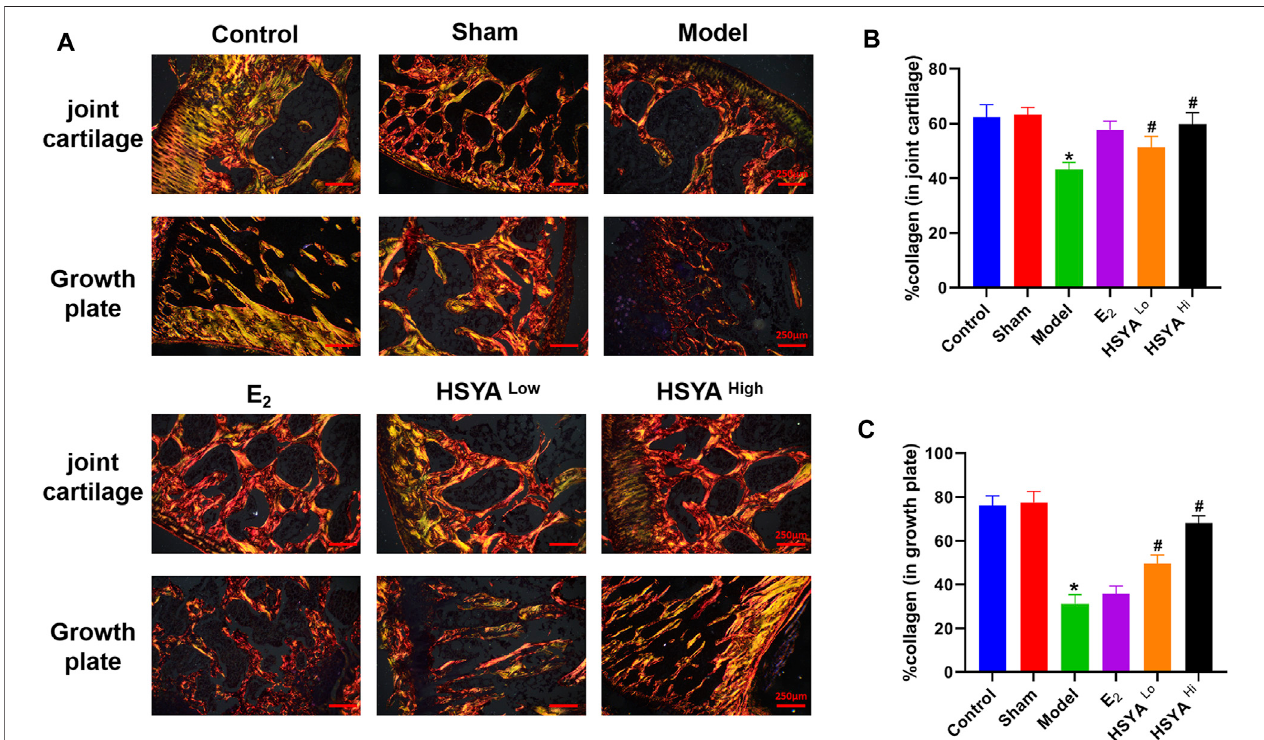
FIGURE 5 | Sirius red staining of collagen. (A) After the epiphysis and growth plate were stained with Sirius red, the collagen was taken on the positive fi lm. (B) IPP6.0 software quanti fi ed the fl uorescence area of the epiphysis in red and yellow-green, and the results were quanti fi ed by the ratio to the total bone tissue area in the image. (C) IPP6.0 software quanti fi ed the fl uorescent area of red and yellow-green at the growth plate, and the results were quanti fi ed by the ratio with the total area of bonetissueintheimage. “ * ” indicates p < 0.05,comparedwiththecontrolgroup,thedifferenceisstatisticallyThedifferenceisstatisticallysigni fi cantcomparedwith the control group. “ # ” indicates p < 0.05, the difference is statistically signi fi cant in the HSYA treatment group compared with the model group.